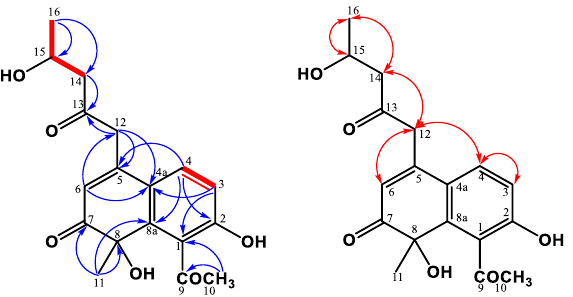
Figure 6. Key 1 H- 1 H COSY ( ━ ), HMBC (H → C), and NOESY (H ↔ H) correlations of 5.